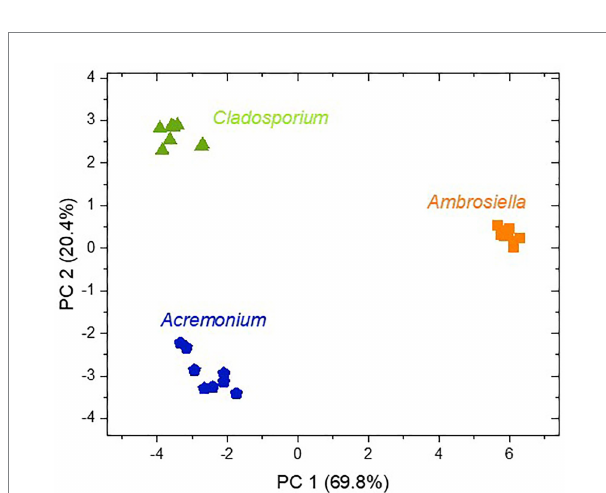
FIGURE 3 Score plot of a principal component analysis with all MVOCs released from the three fungi isolated from X. germanus . The abundances of all MVOC from 7–8 replicates shown in Table 1 were log transformed and used for